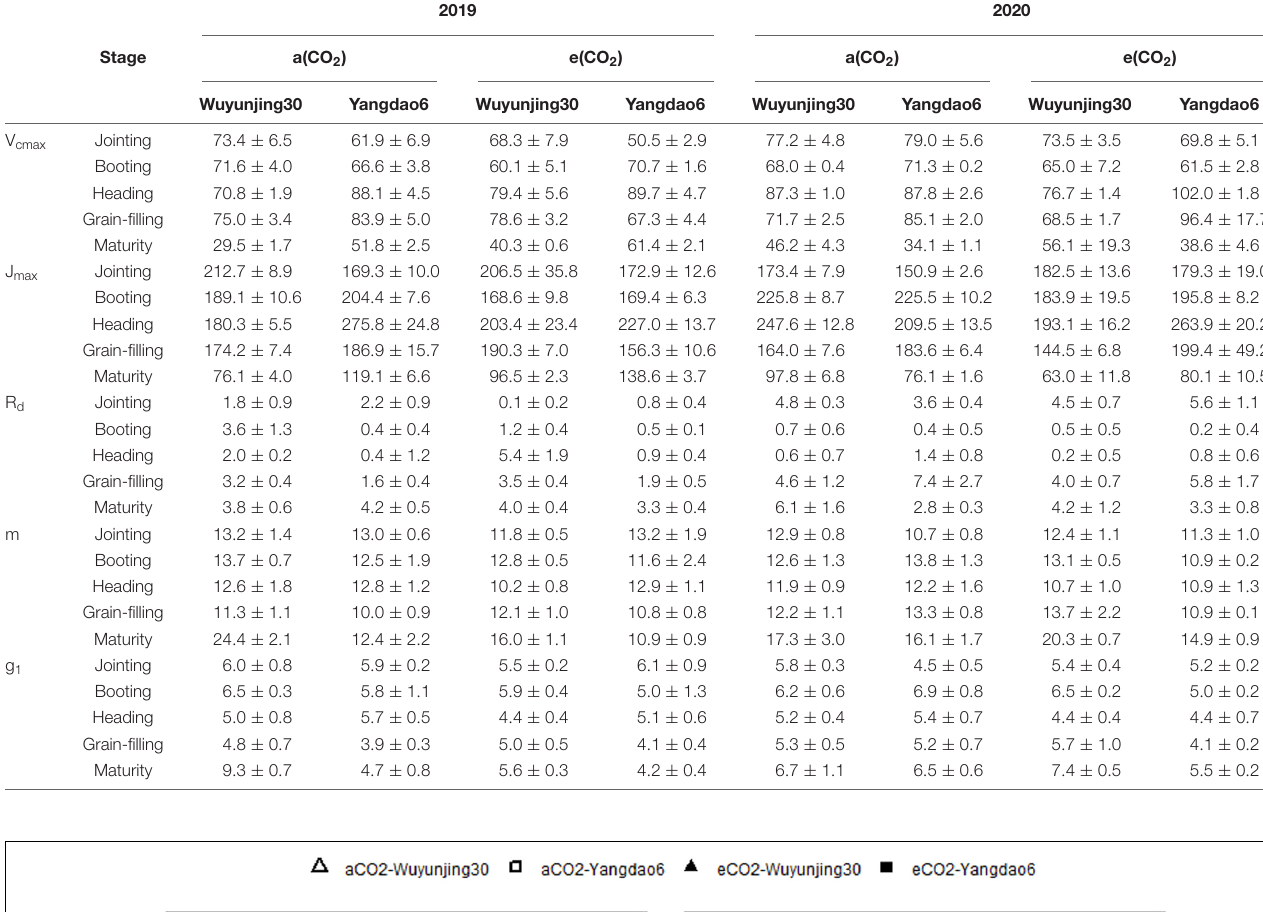
TABLE 2 | Model parameters determined from A net -Ci data in 2019 and 2020.